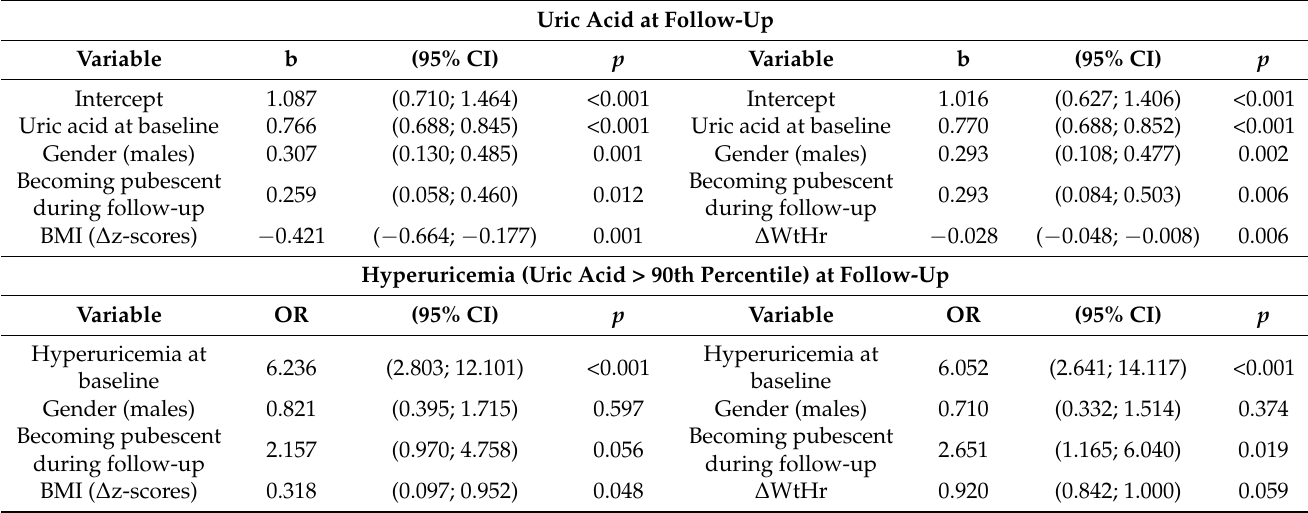
Table 4. Effect of uric acid at baseline, gender, transition from pre-pubescent to pubescent, BMI or WtHr on uric acid at follow-up by a multiple linear regression model. Effect of hyperuricemia at baseline, gender, transition from pre-pubescent to pubescent, BMI or WtHr on hyperuricemia at follow-up by a multiple logistic regression